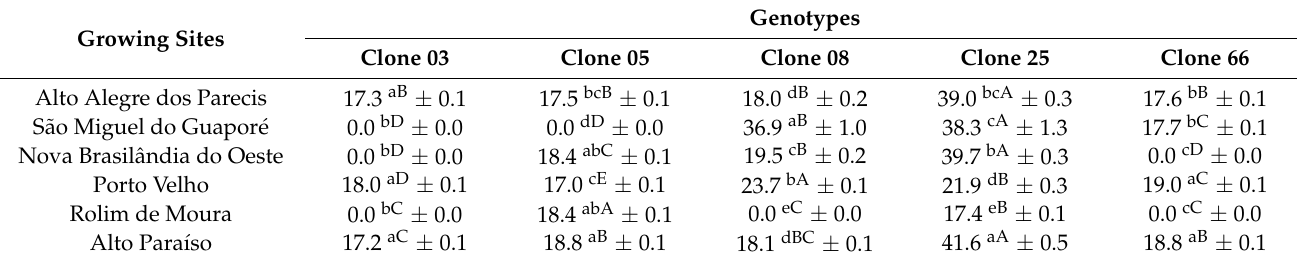
Table 2. Kahweol contents * (mg 100 g − 1 ) for roasted C. canephora intervarietal hybrids cultivated in different growing sites. Genotypes Growing Sites Clone 03 Clone 05 Clone